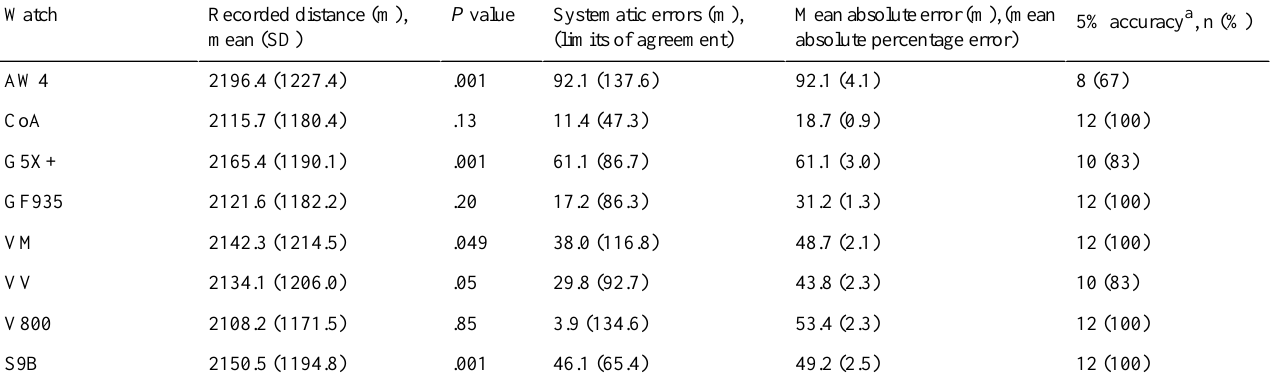
a Percentage at which the distance recorded by each device was within 5% of the reference distance. b n=11. Table 4. Recorded distances and error rates of the eight sport watches obtained in the track and field area when compared with the reference distance of 2104.3 (SD 1167.4) m (n=12).